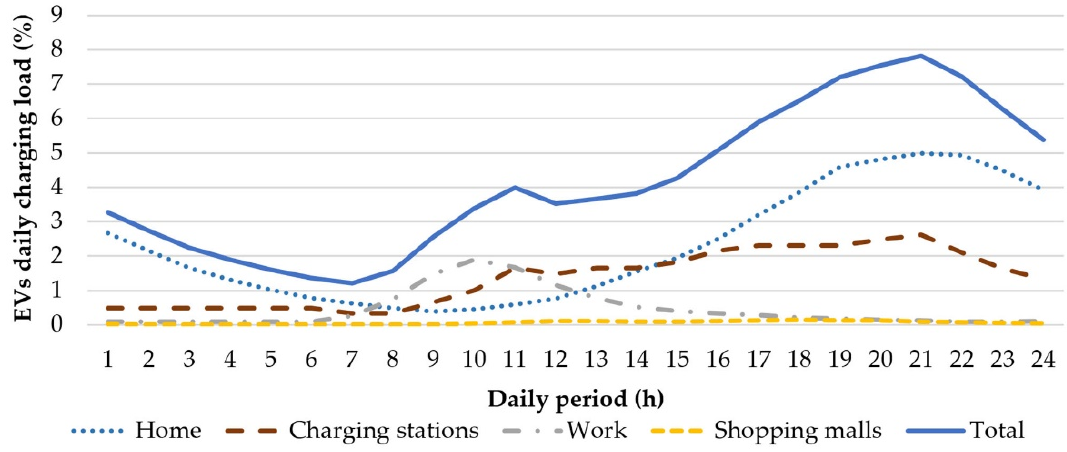
Figure 19. Daily load charging profiles of e-vehicles.